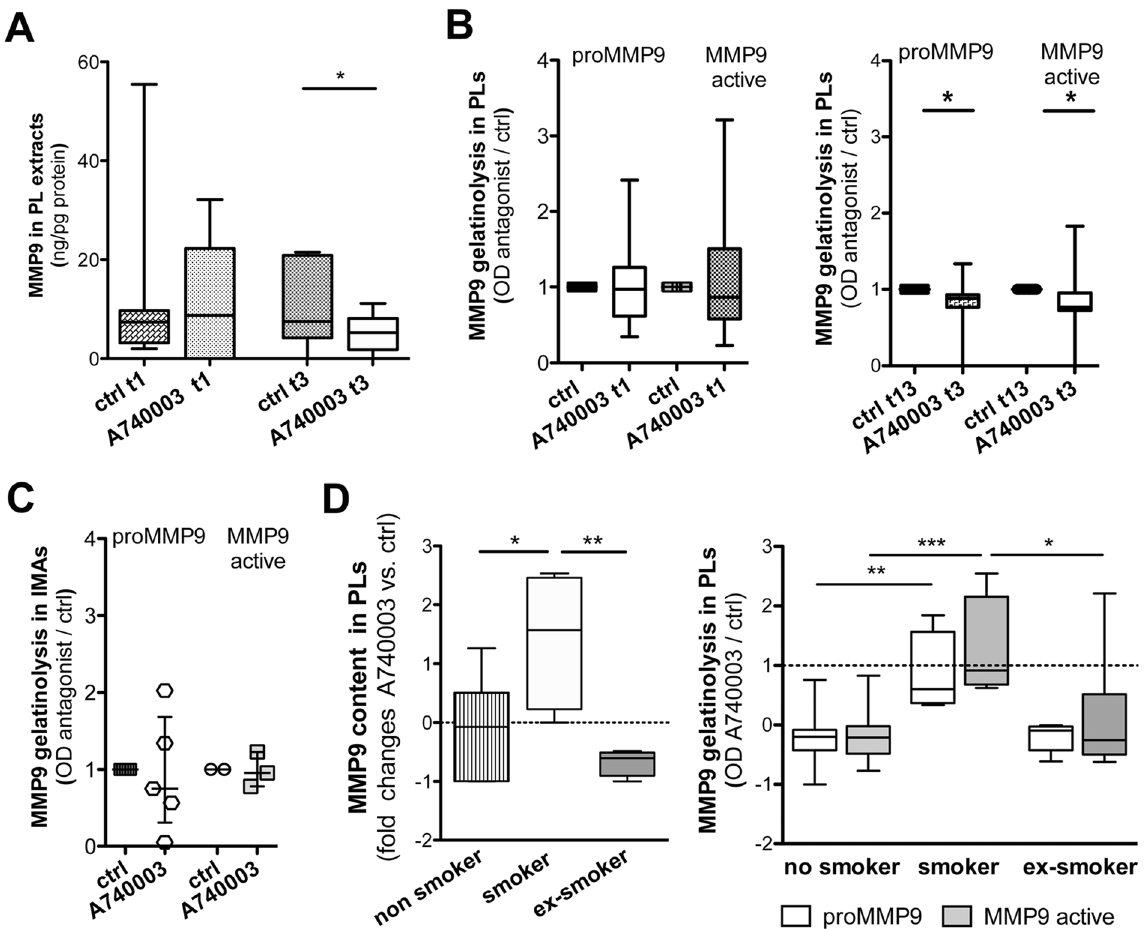
Figure 5. Ex-vivo vessels culture: A740003 effects on MMP9 content and activities. MMP9 content in PL extracts after treatment with A740003 is displayed ( A ). Paired t-test is applied. Quantification of MMP9- related gelatinolytic activities in PL extracts after treatment with A740003 at t1 and t3 is plotted ( B ). Wilcoxon signed rank test is applied. MMP9-related gelatinolytic activities in IMA extracts are presented ( C ) as scatter dot plot with median and interquartile range. A740003 on patients grouped for their smoking status: efficacy in diminishing the MMP9 content and activities is shown ( D ). Dotted line displays the control value in ( D ) histograms. One-way ANOVA with Bonferroni post-hoc test is used. Values displayed as boxes are shown with whiskers 5–95 percentile. Significant differences are shown as * p < 0.05, ** p < 0.01 and *** p <